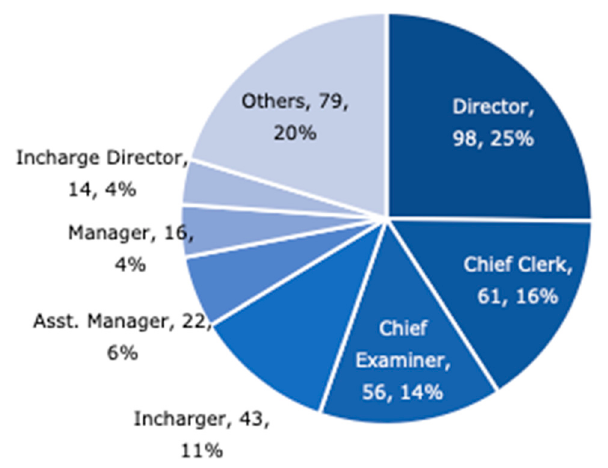
Figure 3. Job title ratio of survey respondents.